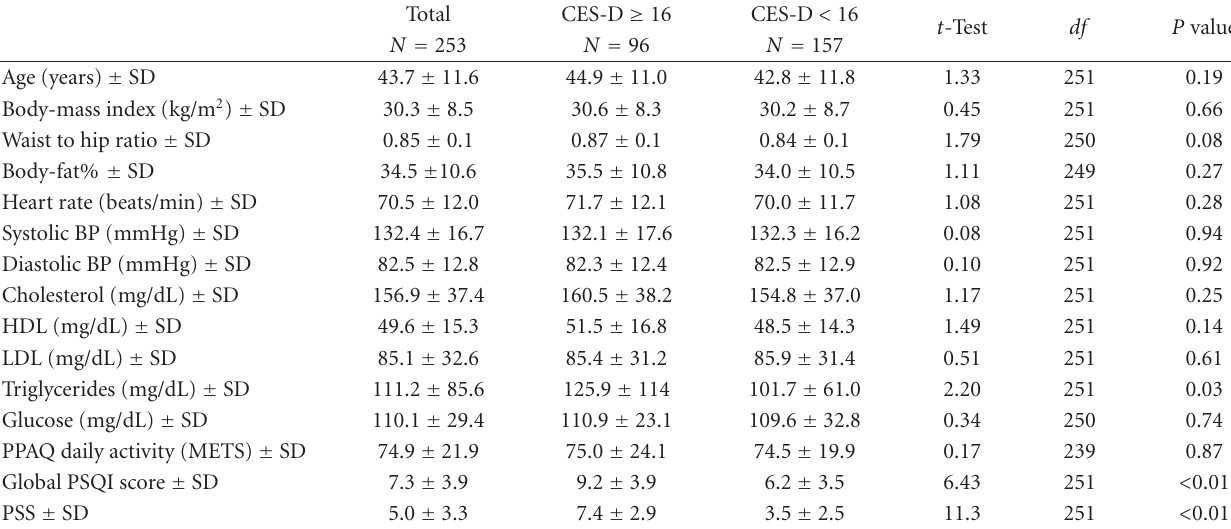
Table 2: Participant characteristics (continuous variables).